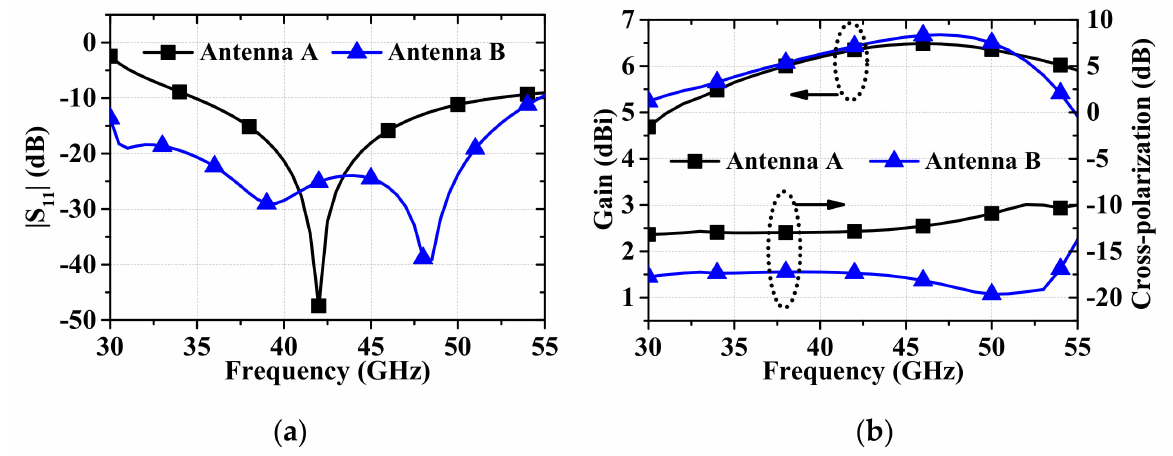
Figure 5. The simulated |S 11 |, gain and cross-polarization of Antenna A and Antenna B: ( a ) |S 11 |; ( b ) gain and cross-polarization.